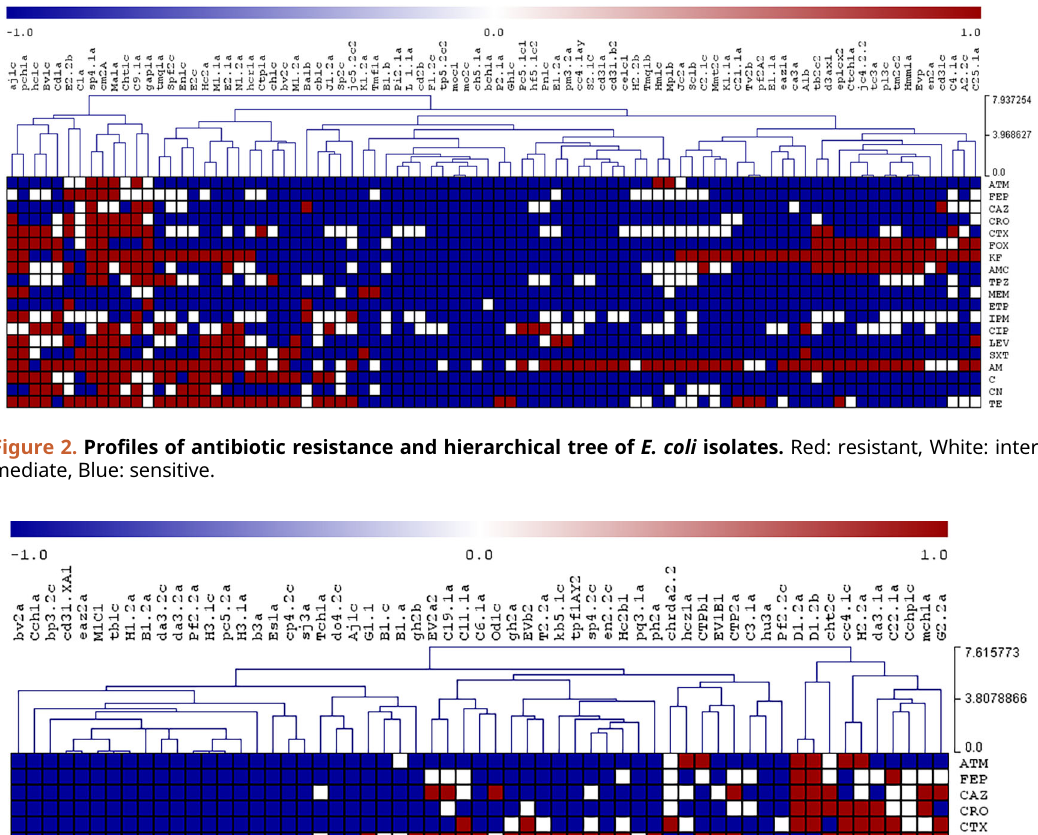
Figure 1. Occurrence of Enterobacterales on 151 samples of ready-to-eat street food in Ambato,